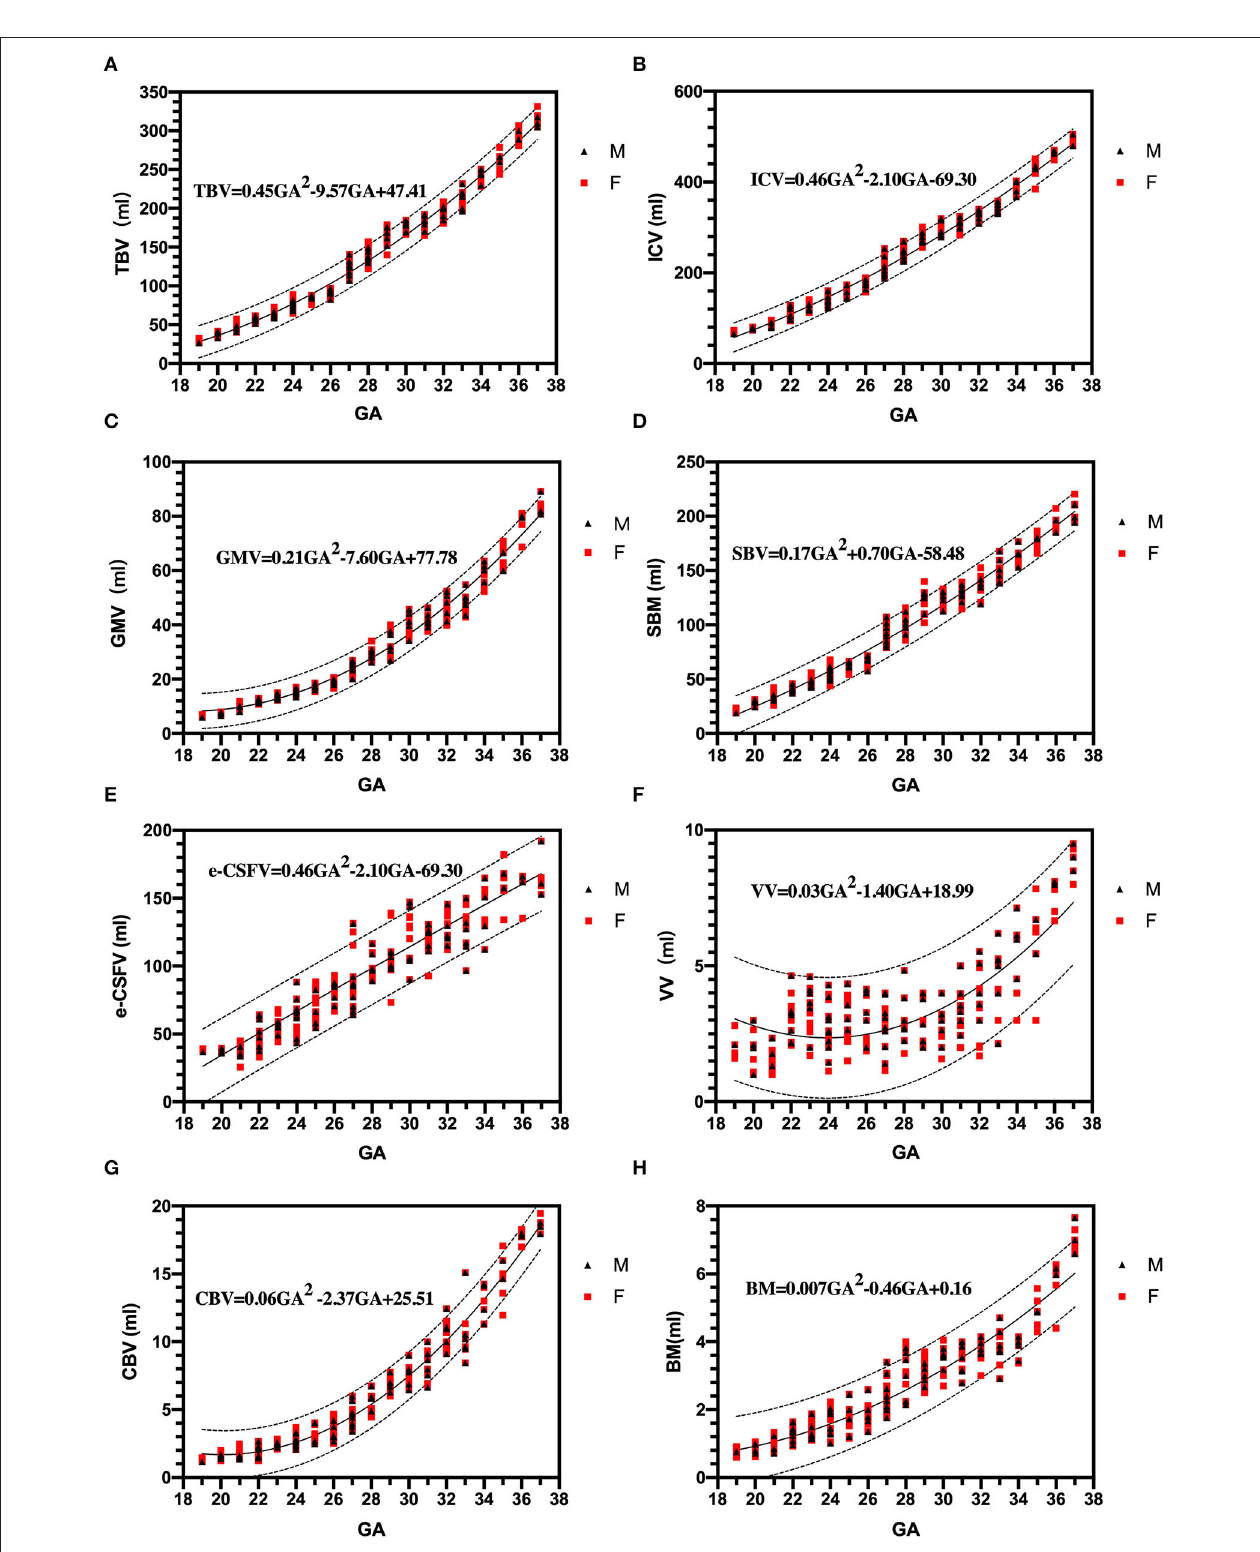
FIGURE 3 | Three dimensional measurements: growth trajectories and centiles. Best fit models for normal control 3D growth trajectories of an intracranial brain tissue, (A) : brain volume (TBV), (B) : intracranial cavity volume (ICV), (C) : gray matter volume (GMV), (D) : subcortical brain volume (SBV), (E) : extra-cerebrospinal fluid (e-CSFV), (F) : lateral ventricles volume (VV), (G) : cerebellar (CBV), (H) : brainstem (BM). Solid lines depict the 50th centile, and dotted lines the 5th and 95th centiles. Red square (F): female fetuses; black triangle (M): male fetuses.